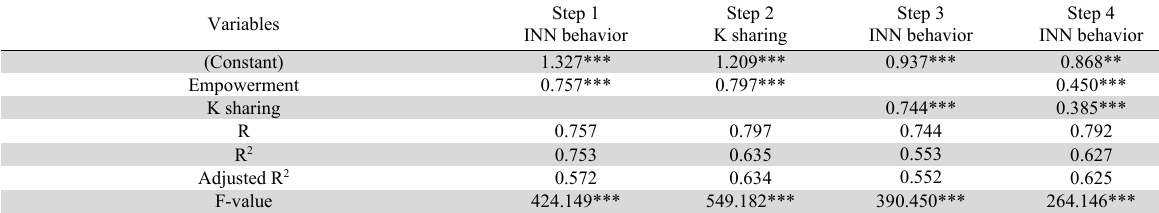
Regression analysis to test hypothesis H1